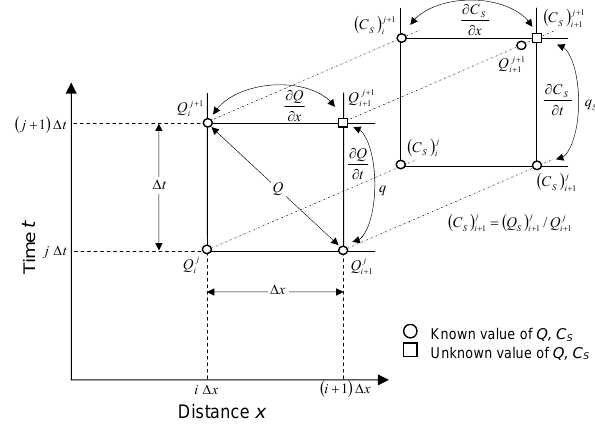
Fig. 3. Time and space derivatives of both Q and C s by finite-difference scheme in kinematic modeling (after Chow, 1959).